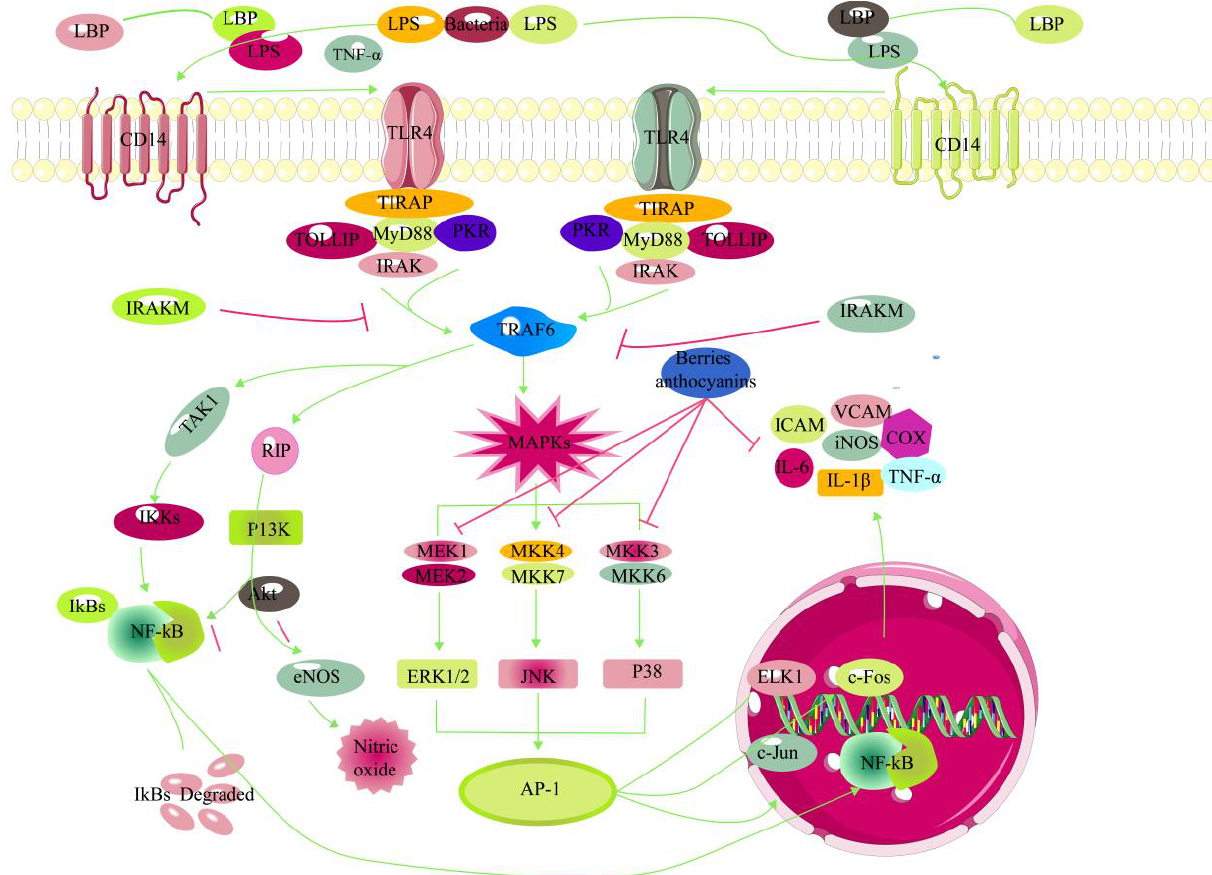
Figure 5. Recent studies on anti-inflammatory mechanisms of berry anthocyanins. The TLR4 is a classical inflammatory pathway. TLR4 receptors generally exist in human T cells, B cells, myocardial cells, vascular endothelial cells, adipocytes, intesti- nal epithelial cells, and other cells. TLR4 receptor can bind with PAMPs and activate NF- κ B through signal transduction. NF- κ B regulates its downstream inflammatory genes, and promotes the expression of inflammatory factors, which plays an important role in the pathogenesis of various chronic inflammatory diseases. TLR4/NF- κ B signaling pathway has two pathways, namely, MyD88 dependent pathway and MyD88 independent pathway. Banach et al. studied the effects of anthocyanins on the inhibition of lipid peroxidation and the levels of inflammatory markers in RAW 264.7 cells stimulated by lipopolysac- charide (LPS). The results show that anthocyanins had good anti-inflammatory activity by inhibiting the levels of IL-1 β , TNF- α , and MDA [99]. Vandevelde et al. prepared